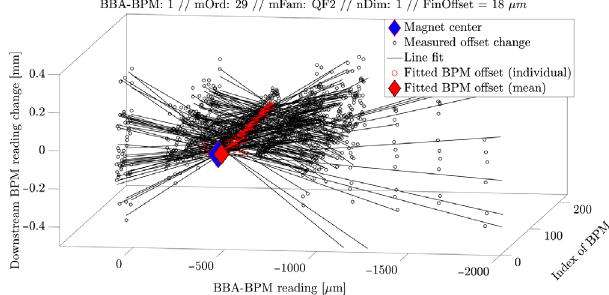
FIG. 7. Illustration of trajectory BBA for the BPM-quadrupole pair BPM4-QF2: data and analysis. The x axis shows the reading of the BPM targeted for BBA; the y axis shows the index of the downstream BPMs; and the z axis the difference in the trajecto- ries as recorded at the downstream BPMs when changing the quadrupole strength from 95% to 105% of the nominal. A black dot represents the measurement for one of the ten steering offsets imparted to the injected beam; the black lines are linear fits. The red dots mark the zero crossing of these lines and the red diamond shows the weighted mean. In this example, the weighted mean is 19 μ m off the actual quadrupole center, much less than the physical misalignment between BPM and quadrupole, about − 500 μ m. Note that after 12 BPMs downstream of the BBA- BPM, beam transmission decreases significantly when the injected beam is steered too much and only five out of the ten steered trajectories can be utilized; after 189 BPMs, no data could be used for BBA due to beam loss. This figure is conveniently created by switching on a plot flag in the SCBBA()